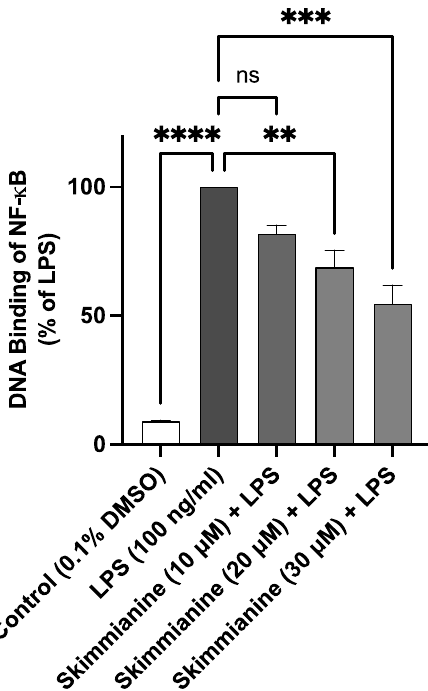
Figure 9. Skimmianine (20 and 30 μ M) decreased the binding of NF- κ B to consensus sites in LPS- stimulated BV-2 microglia. Nuclear extracts were added to wells pre-coated with the NF- κ B consensus site (5 ′ -GGGACTTTCC-3 ′ ), followed by the addition of the NF- κ B p65 antibody. Values are mean ± SEM of at least three independent experiments. A statistical analysis was carried out using one-way ANOVA with a post hoc Dunnett’s test. ns (not significant at p < 0.05); ** p < 0.05; *** p < 0.001; **** p < 0.0001 in comparison with LPS stimulation.